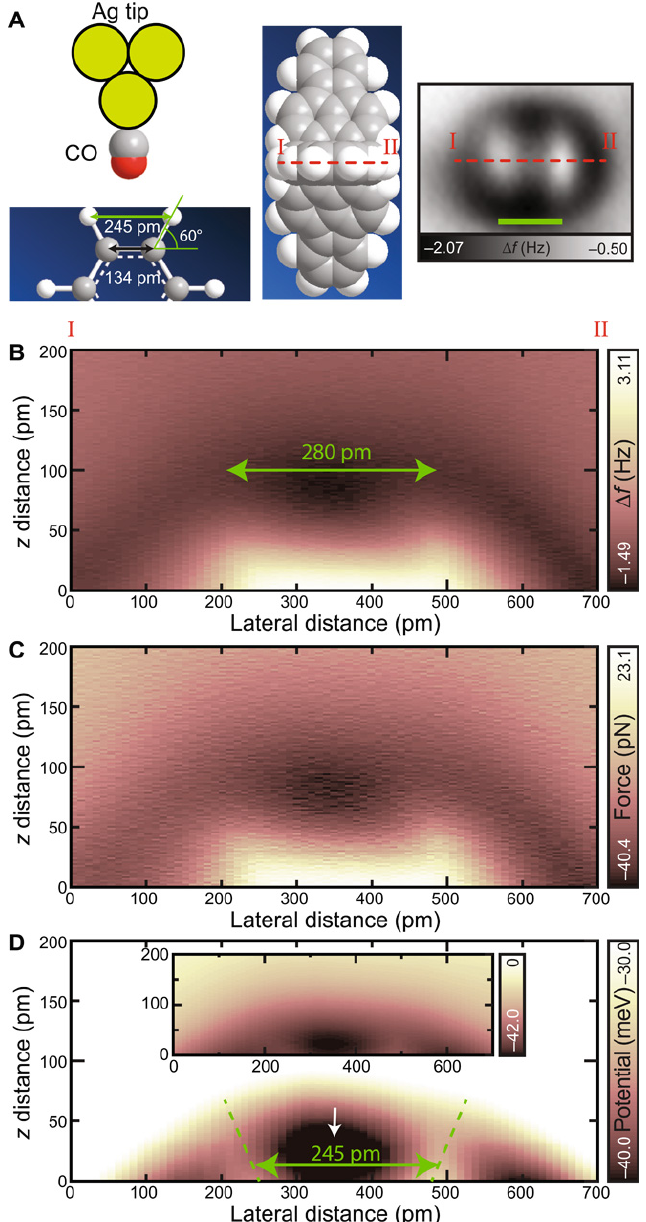
Figure 16. Quantitative measurements of the C-O...H-C bond. ( A ) Schematic drawing of the hydrogen bonding measurement on TFAP with a CO-functionalized tip. Right shows the AFM image. Scale bar, 300 pm. ( B ) Two-dimensional frequency shift map. ( C ) Calculated force and ( D ) potentials. Inset shows the same area with a wider contrast. The z origin was set at the position of the hydrogen atom. Measurement parameters: A = 60pm and V = 0mV. Adapted with permission from American Association for the Advancement of Science from Figure 3 in